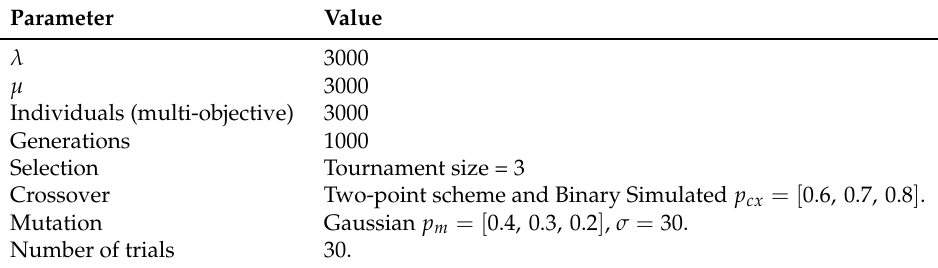
Table 5. Parameters of the GA.